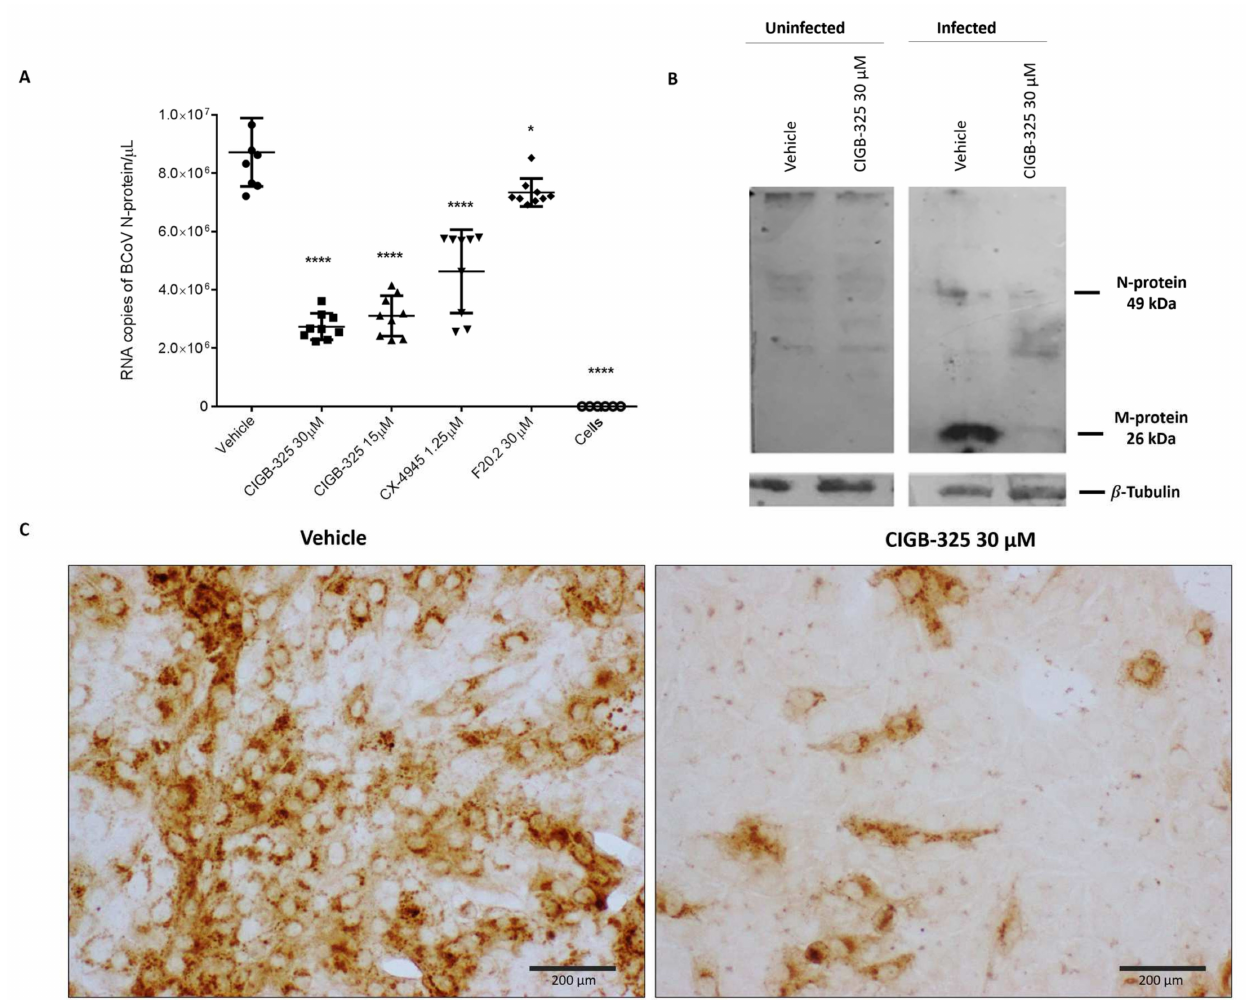
Figure 2. Impact of CIGB-325 on RNA copies of N protein and intracellular protein levels of N and M protein. MDBK cells were treated with the drugs 1 h before the viral challenge. Afterward, cells were infected with BCoV-Mebus (70,000 TCID 50 /well), and the appropriate drug’s concentration was maintained. Effect of CIGB-325 on the RNA copies of N protein and viral M and N proteins levels was investigated using qRT-PCR ( A ) and Western blot ( B )/ immunocytochemistry ( C ), respectively. ( A ) qRT-PCR reaction was performed with specific oligonucleotides corresponding to N protein. N expression was normalized to GAPDH and HMBS genes and expressed as RNA copy number obtained after extrapolation in a calibration curve. Values are presented as mean ± SD (n = 9). Statistically significant differences between vehicle and drug treatment are represented as * p < 0.05 and **** p < 0.0001, determined using one-way ANOVA followed Dunnett post-test. ( B , C ).